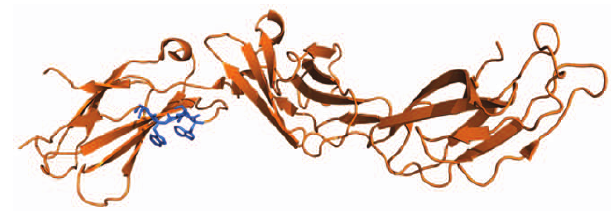
Figure 2. The crystal structure of the human granulocyte colony-stimulating factor (GCSF) receptor. The structure of the GCSF receptor (PDB:2D9Q [42]) is reported in orange. Residues corresponding to the WS.WS motif (residues 295–299) are shown in blue. doi:10.1371/journal.pone.0022270.g002 PLoS ONE |